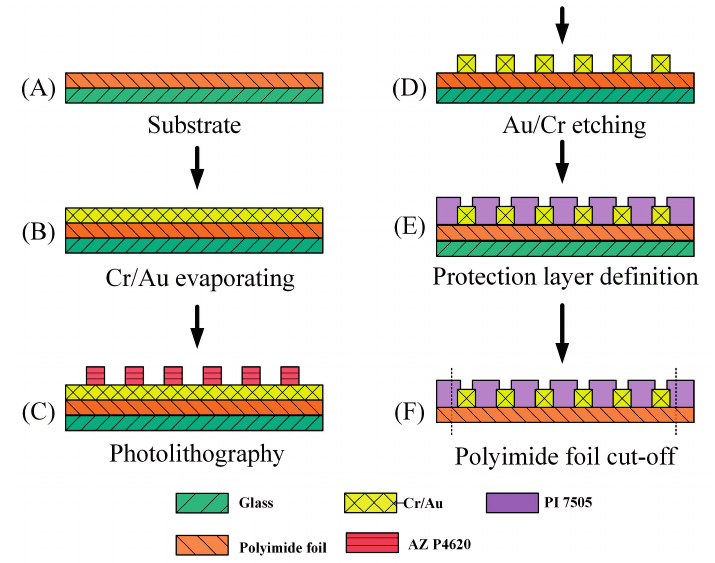
Figure 2. Production process of flexible three-in-one micro